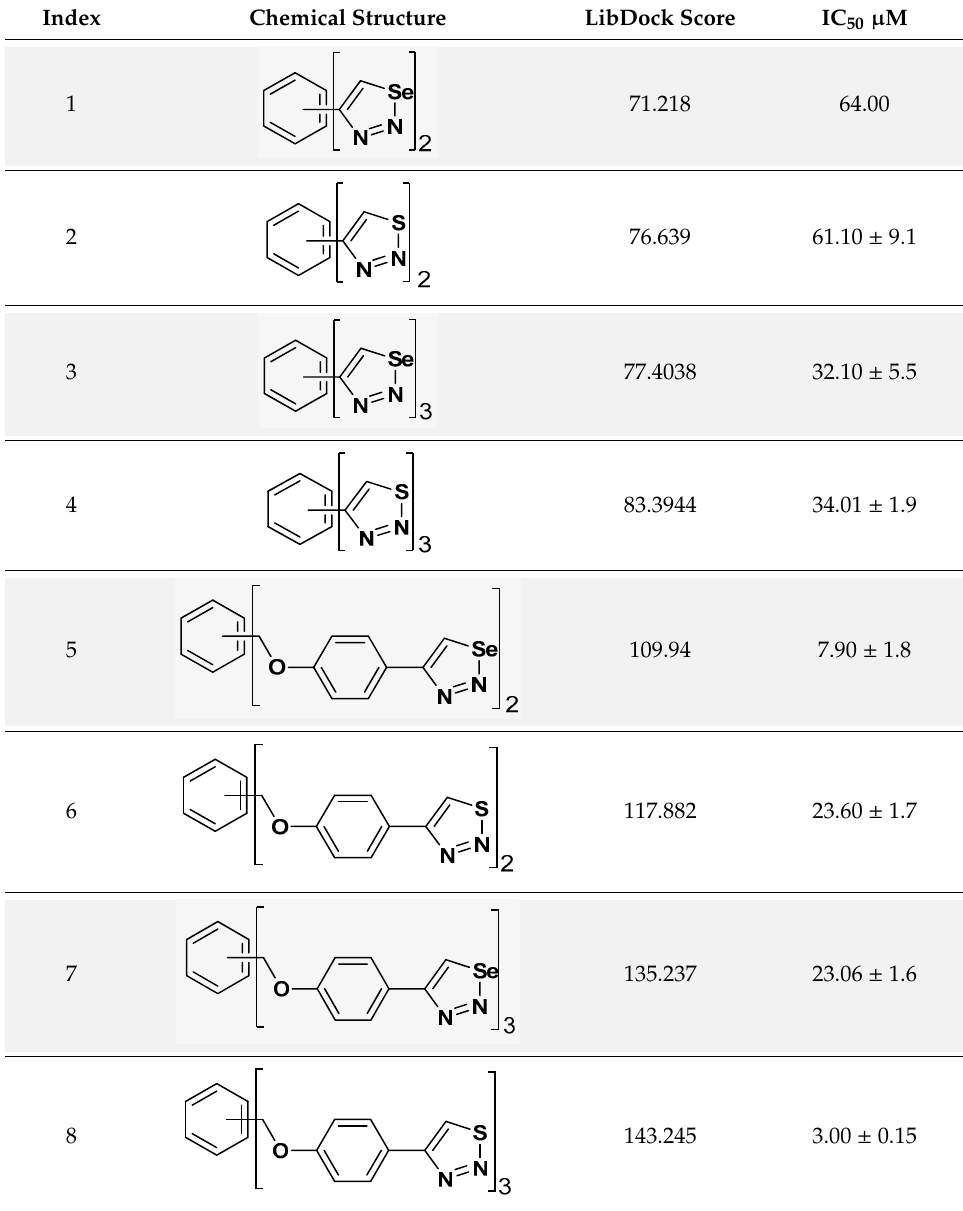
Table 1. Enzyme inhibitory activities of a series of selected multi-arm 1,2,3-selenadiazole and 1,2,3- thiadiazole benzene derivatives ( 1 – 12 ) .